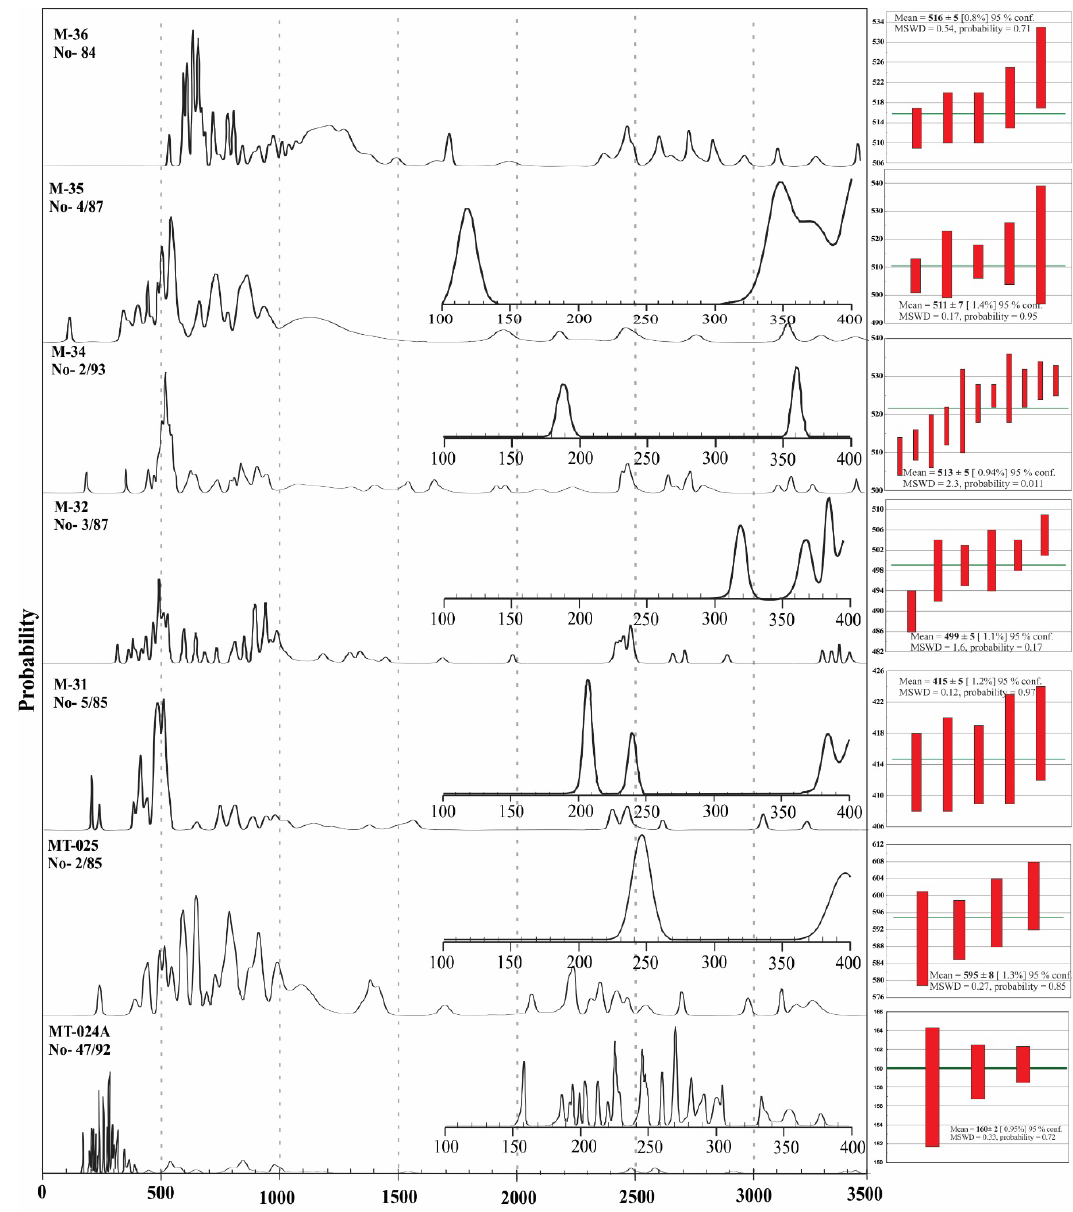
Figure 7. Normalized probability plot of detrital zircon U-Pb ages from this study, collected from the northern section of the Katha-Gangaw range. Samples include MT-024A, MT-025, MT-31, MT-32, and MT-34. Samples M-35 and M-36 are garnet–staurolite schists, whereas all other samples are quartzites. No = number of grain analyses in which the denominator indicates the total number and the numerator indicates the number of grains younger than 400 Ma. The right figure of each sample indicates the maximum depositional age.